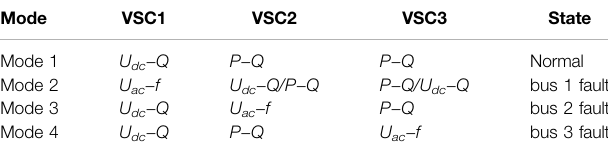
TABLE 1 | Three-port SOP control